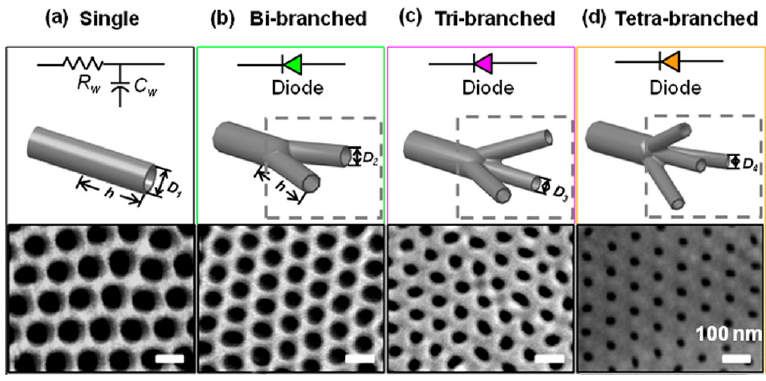
Figure 13. Equivalent circuit components, schematic diagrams, and SEM images of the final opening end of the prepared nanochannels; the scale bar is 100 nm. ( a ) alumina single nanochannel; ( b ) bi-branched alumina nanochannel; ( c ) tri-branched alumina nanochannel; and ( d ) tetra-branched alumina nanochannel. With an increasing number of branches, the pore diameters at the branch opening end decreased. Reprinted with permission from